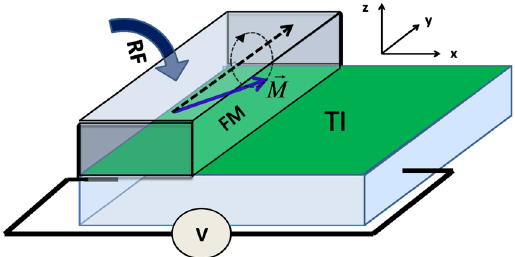
Figure 1. Schematic view of the setup for observing the IEE. A TI thin film is covered partly by a ferromagnetic metal. When the magnetization of the ferromagnet is stimulated to precess around the y axis, by using a radio frequency signal, a spin bias polarized along the y direction will be created in the covered region of the TI film, and electrical current along x-axis will be generated due to the